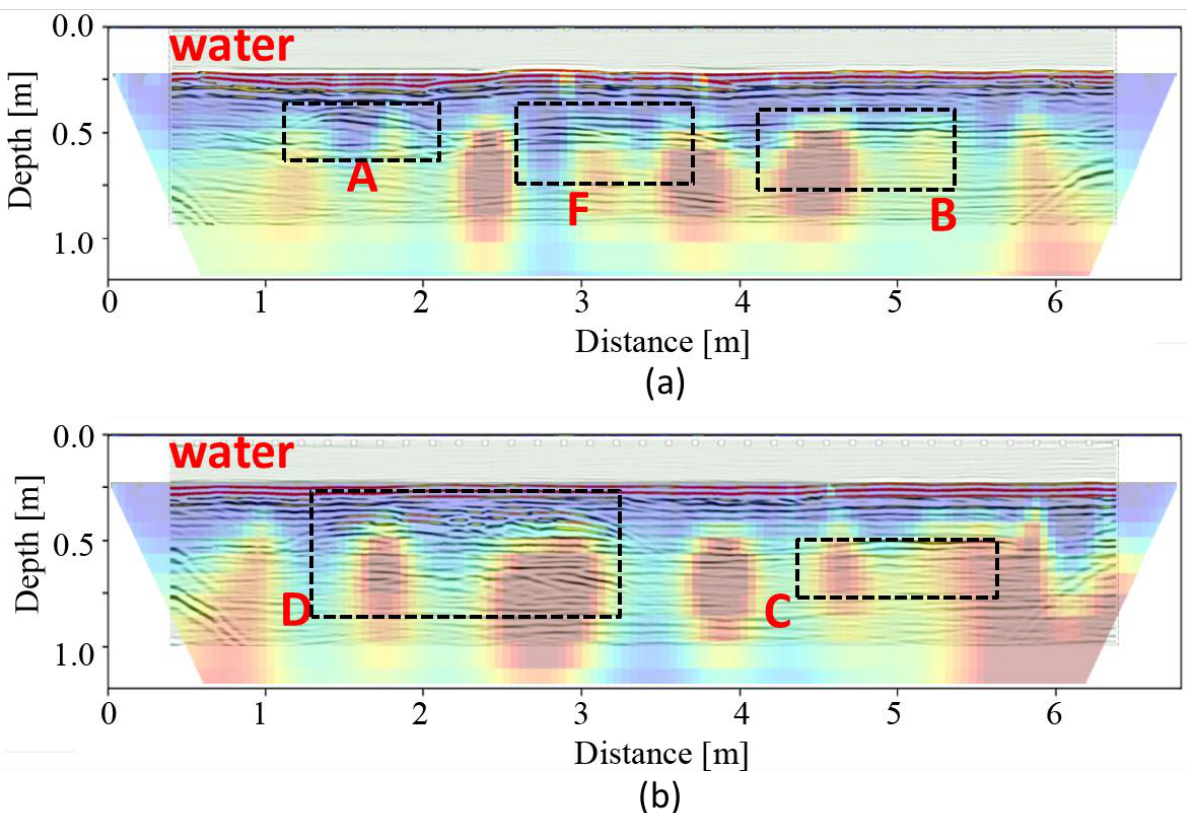
Figure 18. Model co-rendered GPR and ERT data acquired along the two main sections ( a , b ) in WP2.